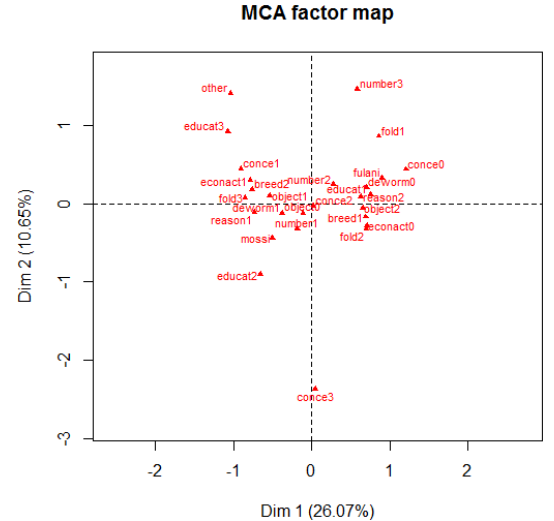
Figure 2. Graphic representation of modalities on axis 1 and 2 (see Table 1 for signification of